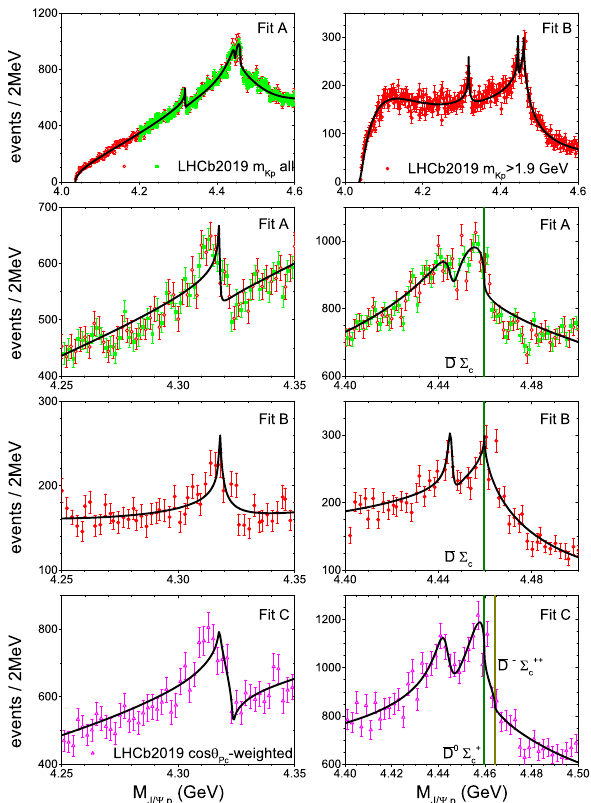
Fig. 3 Fit of the J /(cid:2) p spectroscopy of (cid:3) b → J /(cid:2) pK − . All the datasets are from Ref. [5]. In Fit A the data is from the ‘ m Kp all’ case, where the red open circle is from Fig. 1 and green square is from Fig. 3 of Ref. [5]. In Fit B the data is from the ‘ m Kp > 1 . 9 GeV’ case. In Fit